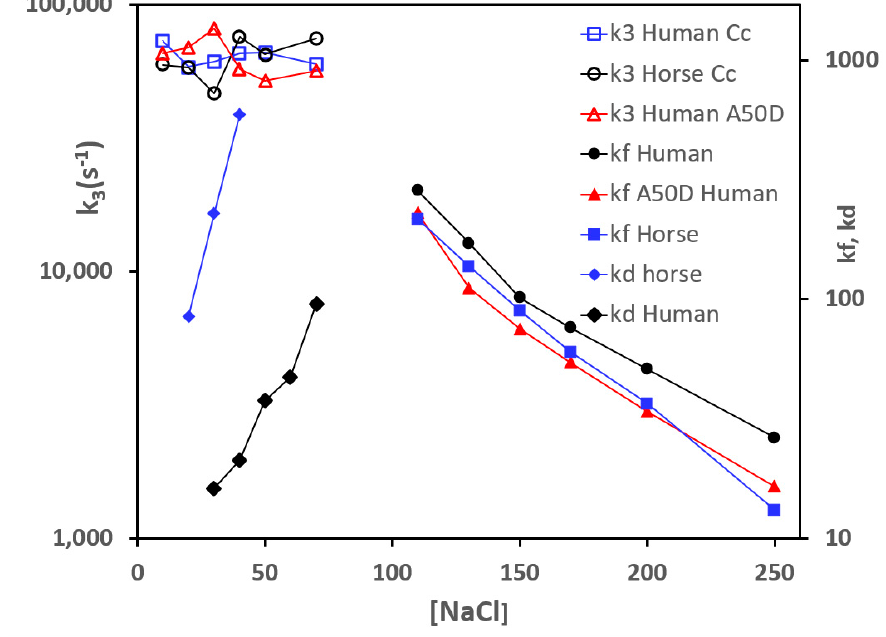
Figure 5. Laser-induced electron transfer from horse, human, and human A50D Ru-39-Cc to bovine CcO. The rate constants k 3 , k d , and k f were measured as described in the text . k 3 and k d are in s -1 , while k f is in μ M -1 s -1 . The solutions for measuring k 3 and k f contained approximately 8 μ M Ru-39-Cc and 15 μ M CcO in 5 mM TrisCl, pH 8.0, 0.1% dodecyl maltoside, 10 mM aniline, and 1 mM